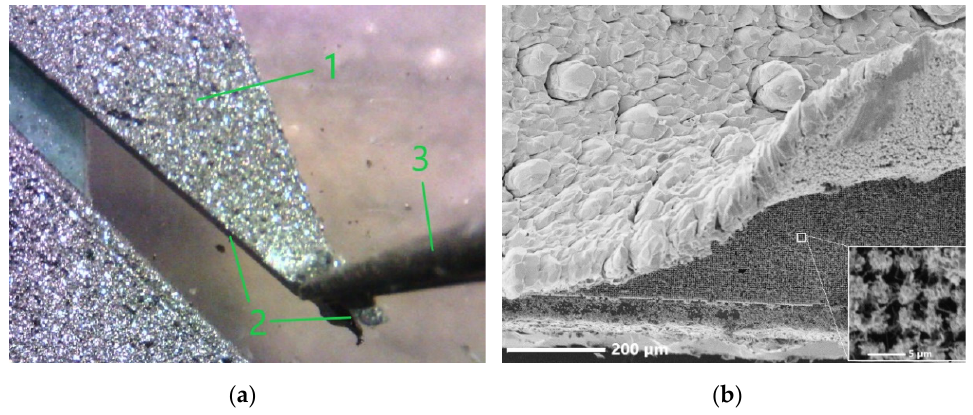
Figure 3. Obtaining free-standing films: ( a ) trial mechanical detachment of one of the fabricated films (1) from the substrate (2) using tweezers (3) (a photograph taken with an optical digital microscope; the size of the displayed area in the plane of the sample surface is ~5.1 × 3.8 mm). ( b ) The edge of the film N1 peeled off the substrate (a SEM image); the inset shows the substrate area with the system of Si whiskers after peeling off the film.